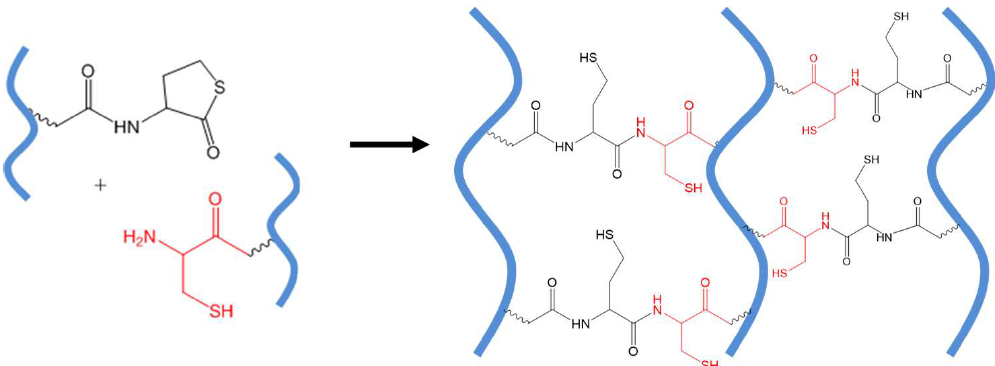
Figure 9. The native chemical ligation (NCL) reaction between polymers presenting thiolactone (a cyclic thioester) and a 2-aminoethanethiol group does not release any soluble thiol by-product as in the traditional NCL reactions. All thiols groups are immobilized onto the covalent network of crosslinked polymers.